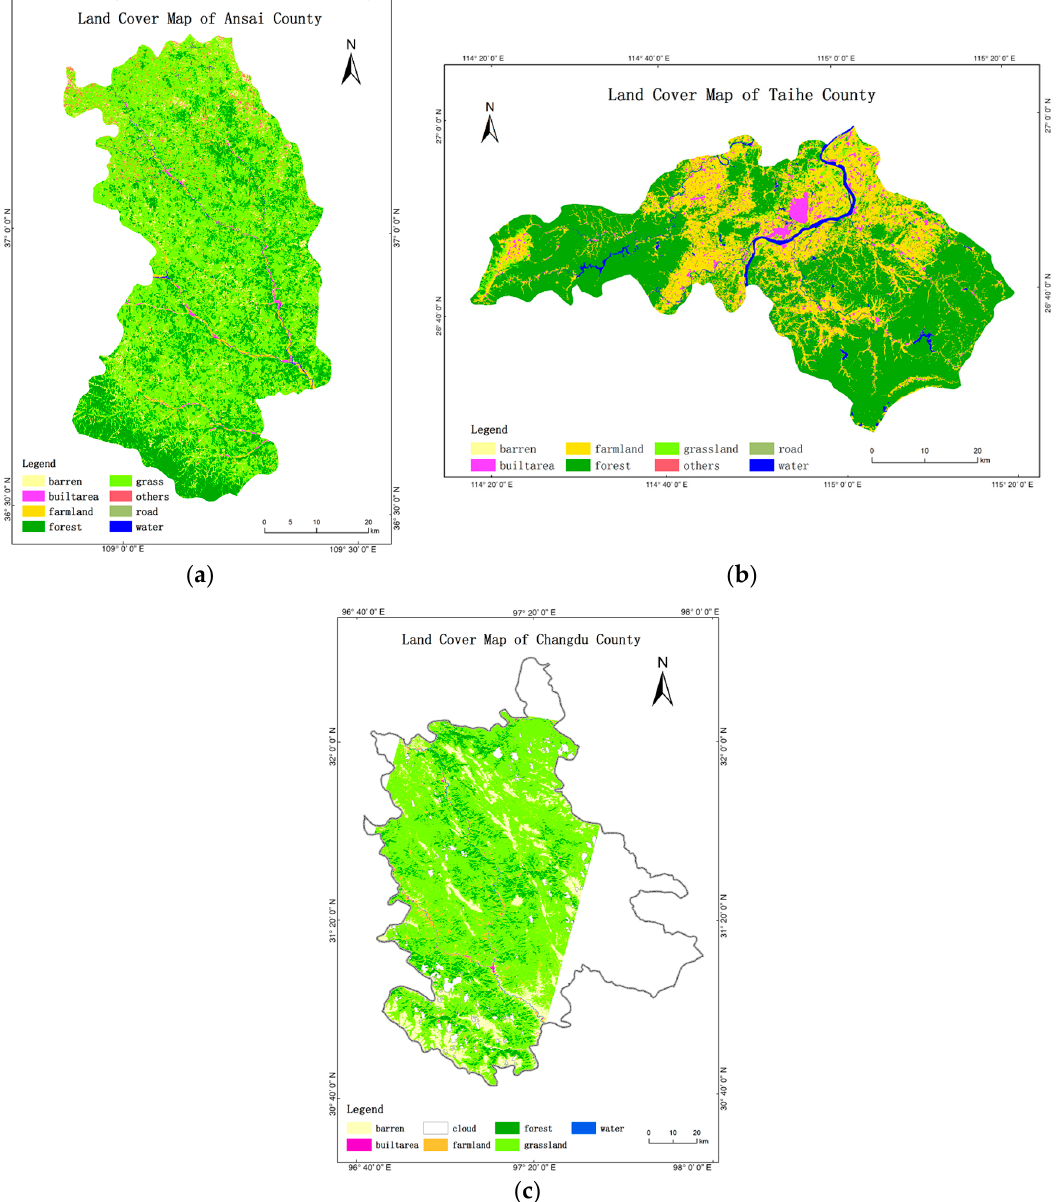
Figure 10. Land cover maps for: ( a ) Ansai County; ( b ) Taihe County; and ( c ) Changdu County.